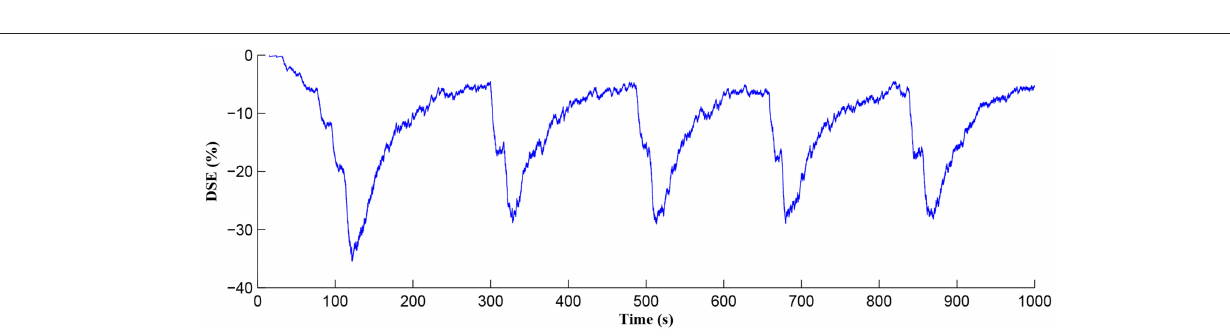
FIGURE 10 | DSE signaling pathway from the postsynaptic neuron, which correlates with the activity of the postsynaptic